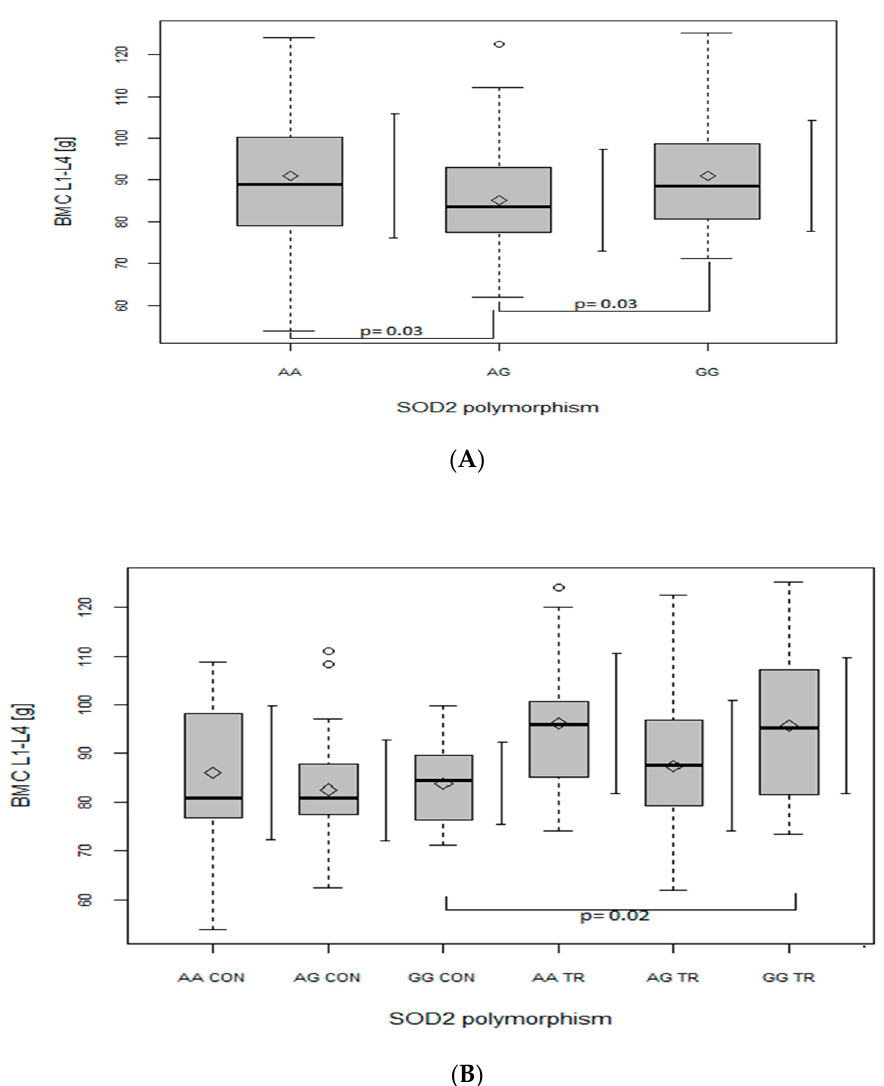
Figure 1. The effect of SOD2 polymorphism on bone mineral content (BMC) (g) of the lumbar spine (L1–L4). ( A ) In the whole group; main effects: SOD2 ( p = 0.02; F = 4.23). ( B ) In control (CON) and trained (TR) group; main effects: SOD2 ( p = 0.01; F = 4.67). TR vs. CON ( p = 0.000000001; F = 18.1). Key: ◊ —mean; ○ —outliers value; boxplots—median Q1–Q4 and mean ± SD.